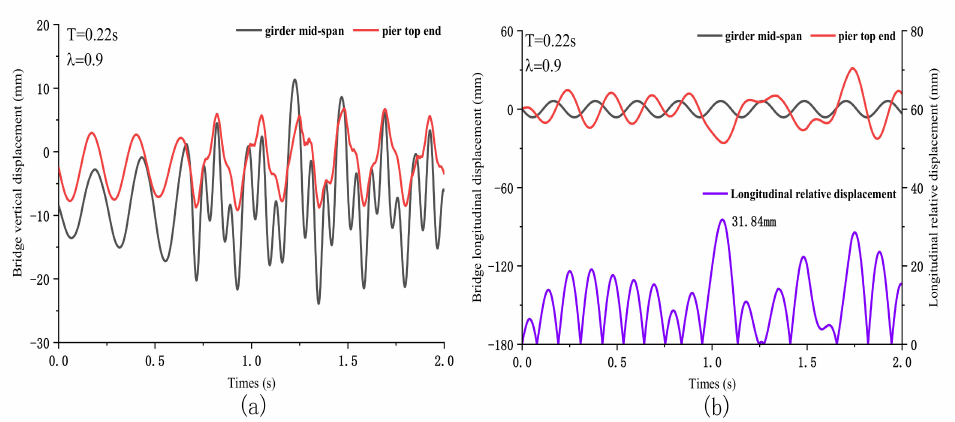
Figure 5. Bridge displacement response considering different separation conditions: ( a ) vertical displacement, and ( b ) longitudinal displacement.